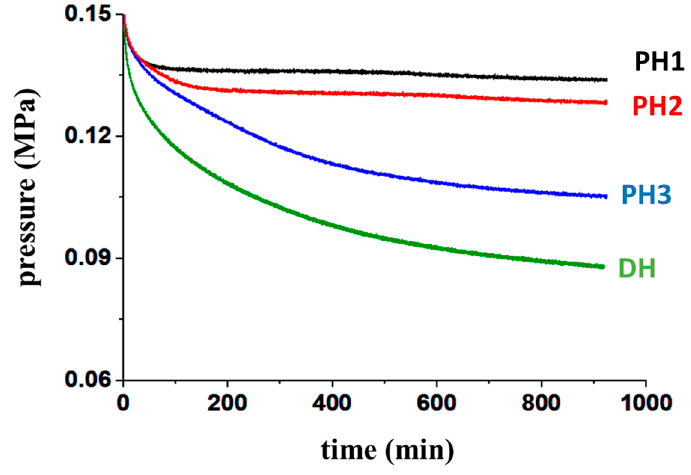
Figure 2. H 2 pressure vs. time for PH x at 298 K and an initial pressure of 200 KPa. The results with the getter sample (DH) prepared by mixing D 4vi with Pd/C at a